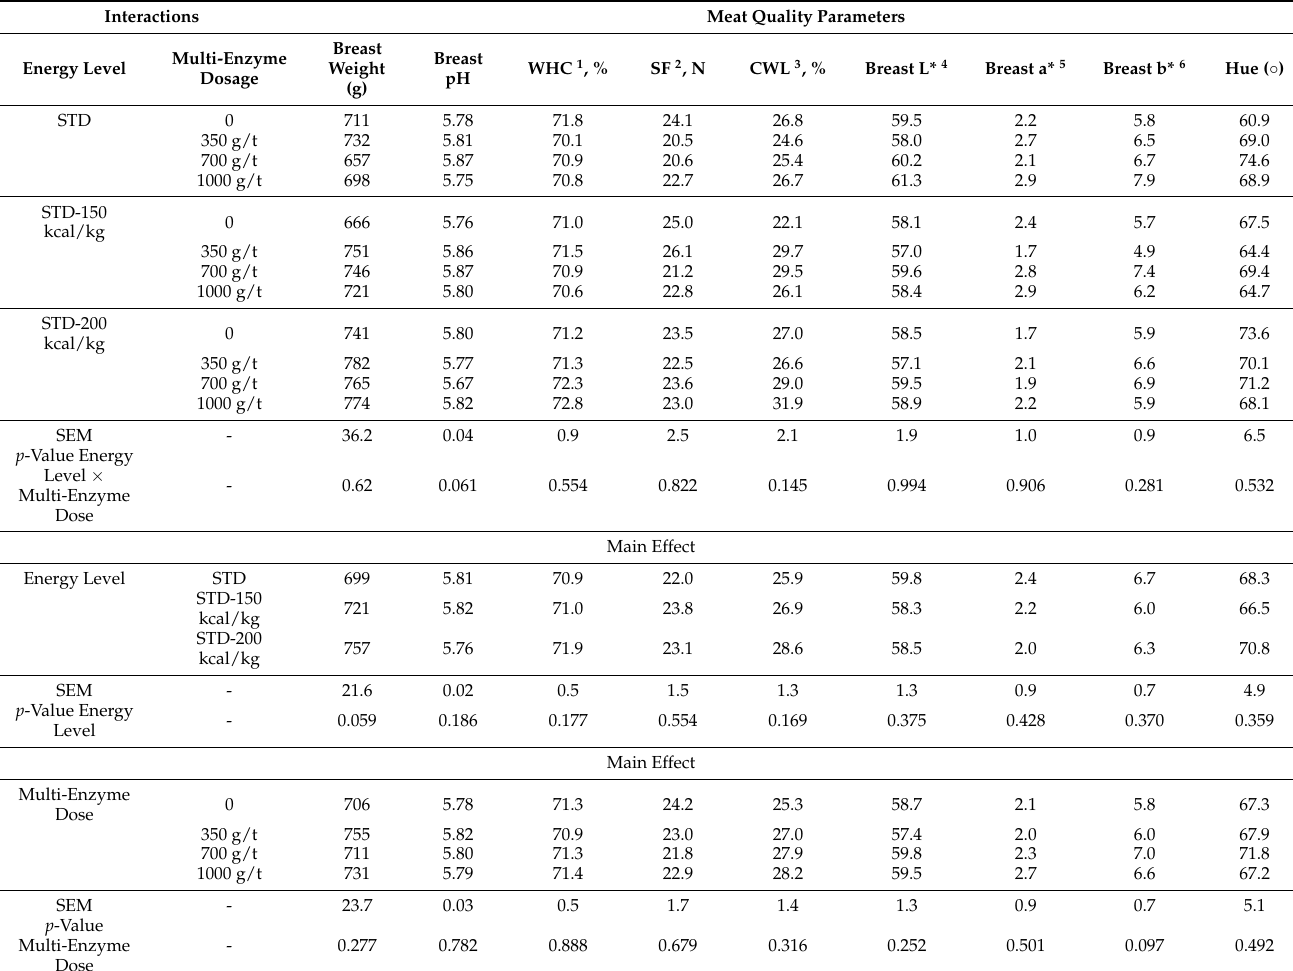
Table 5. Effects of multi-enzyme super-dosing in reduced energy diets on meat quality parameters of broiler chicken. Interactions Meat Quality